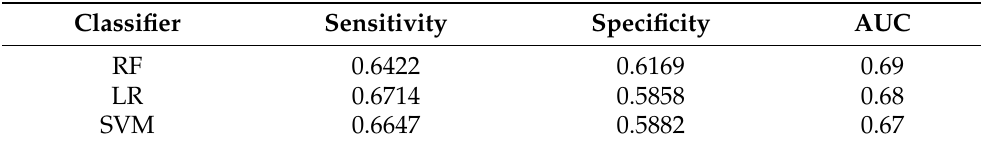
Table 13. Comparison of machine learning